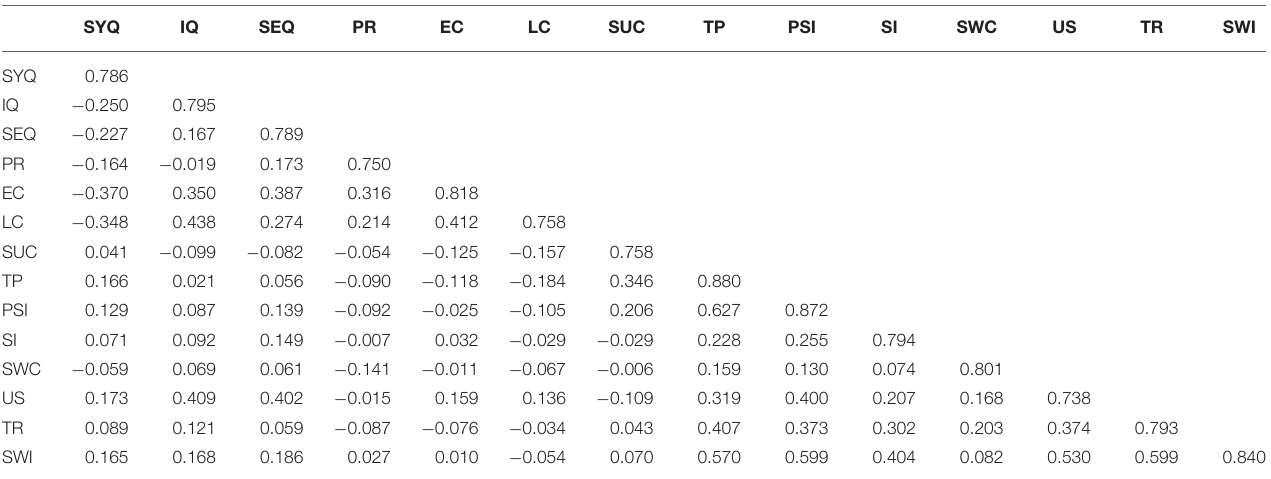
TABLE 3 | Discriminant validity.